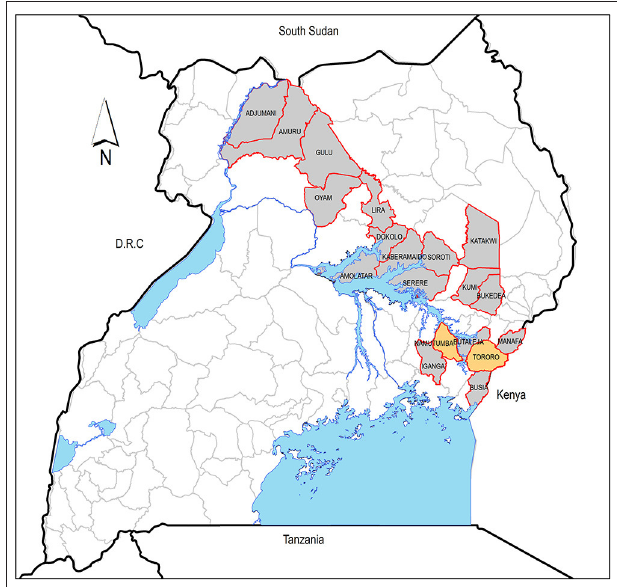
FIGURE 2 | Districts in Uganda where cattle are mostly traded. The yellow districts (Namutumba and Tororo) are where data was collected from. Water bodies are shown in